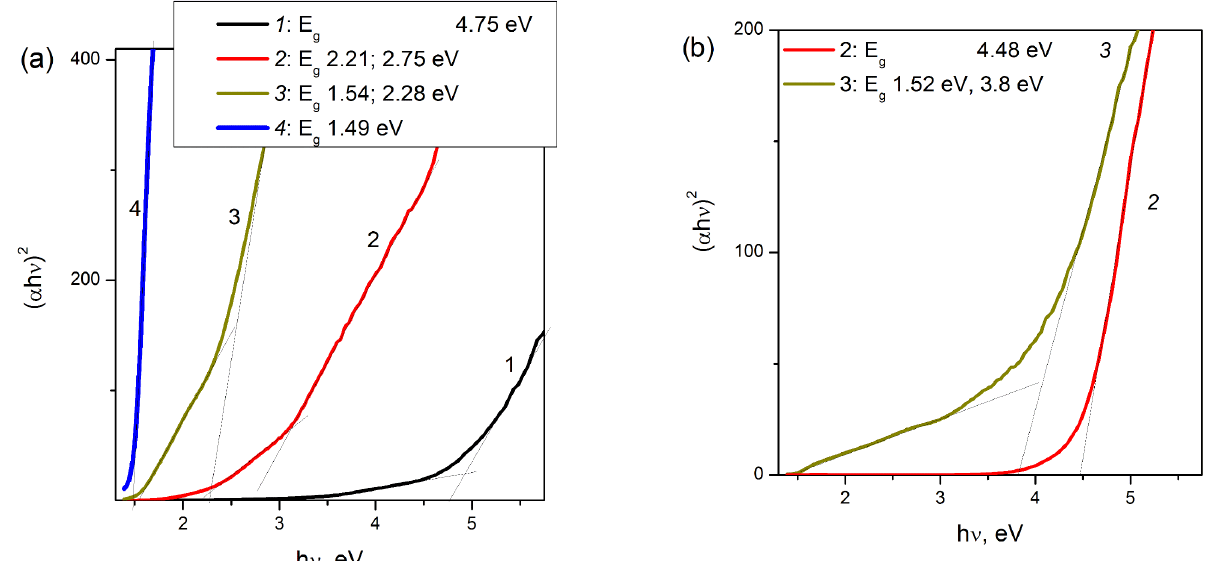
Figure 7. The ( α hv ) 2 plot for determination of direct band gap for samples of Cu-SST-series ( a ), Cu-exchanged MFI ( b , 2) and Cu-impregnated ZSM-5 ( b , 3). The copper loadings are 1 (1), 2 (2) and 16 wt.% (3). Bulk CuO (4).